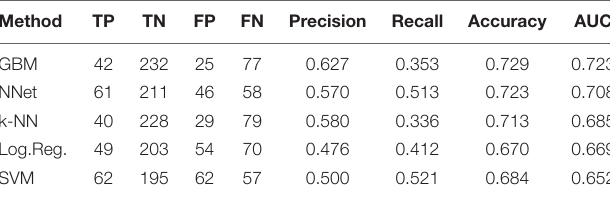
TABLE 1 | Cross-validation performance metrics for five machine learning methods trained to predict ABC-16 relative efficacy.